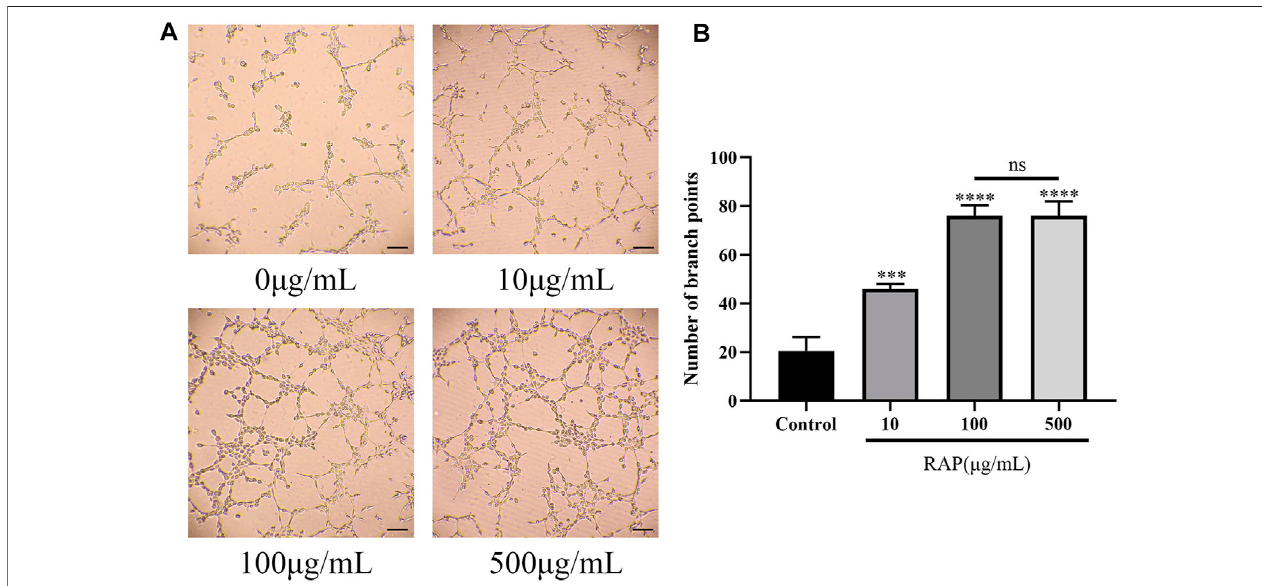
FIGURE 2 | RAP promoted EC tube formation (A) Representative images of tube formation after EC treatment with different concentrations of RAP for 4 h (100× ampli fi cation, scale bar = 100 μ m); (B) Number of branch points of ECs treated with different concentrations of RAP for 4 h. Data are presented as means ± SD. *** p < 0.001, **** p < 0.0001 compared with the control